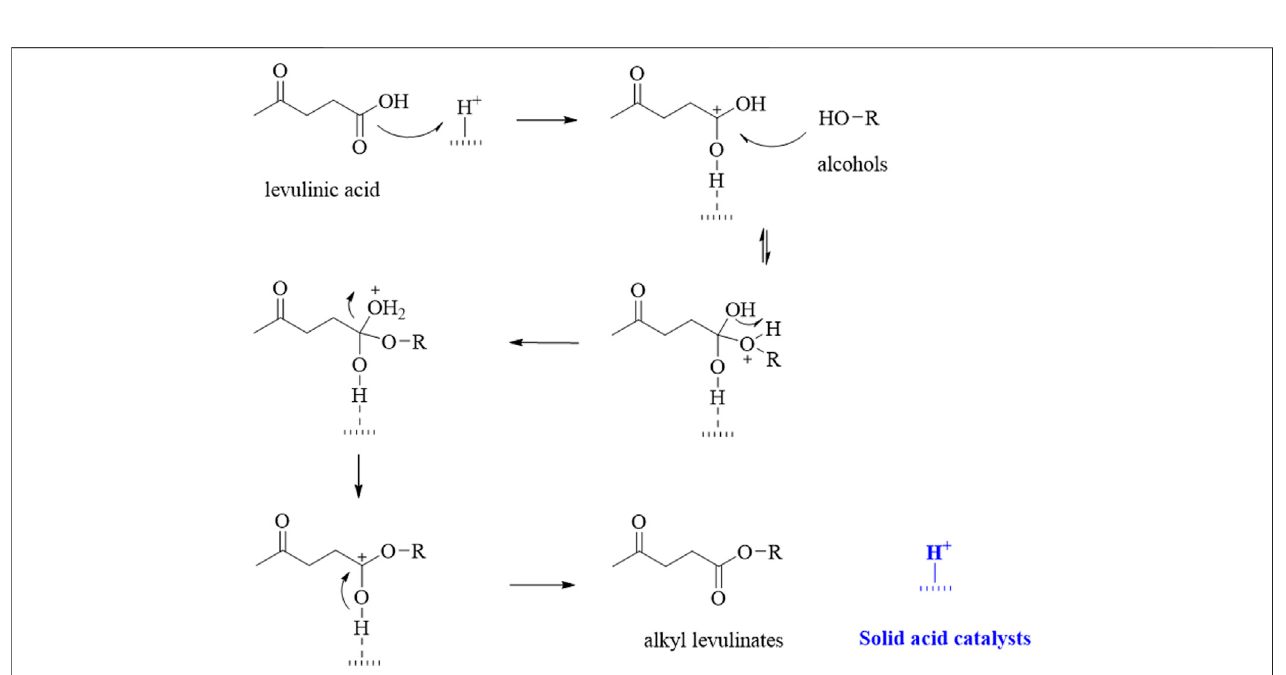
FIGURE 1 | Plausible reaction mechanism of levulinic acid (LA) esteri fi cation with alcohol.